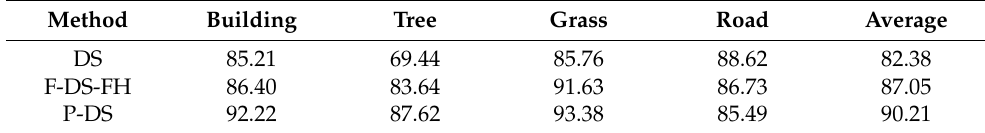
Table 7. Classification accuracy (%) for land cover classes on test set 2.